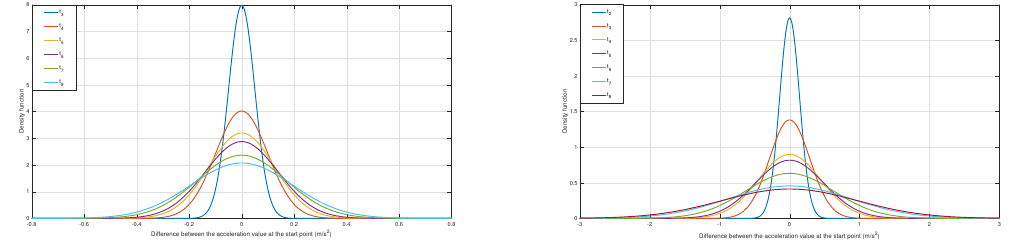
Figure 8. Density functions of the longitudinal